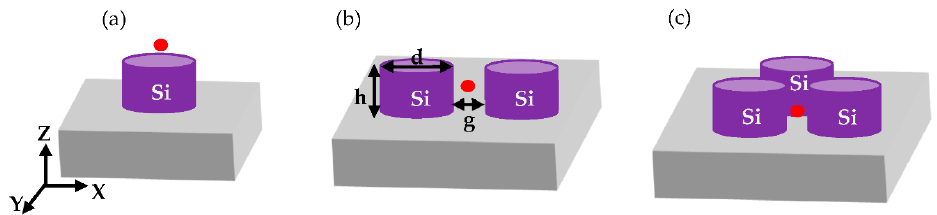
Figure 9. Schematic illustration of: ( a ) cylinder NS on SiO 2 substrate with a point dipole, which represents a fluorophore situated above the NS; ( b ) dimer NSs; and ( c ) trimer NSs on SiO 2 substrate with a point dipole situated in the gap. Table 2. Comparison of the fluorescence enhancements of an emitter coupled with arrays of differ- ent geometries, 7 nm above the structure at λ = 650 nm for an x -oriented dipole (top row) and aver- aged over dipole orientation (bottom row).